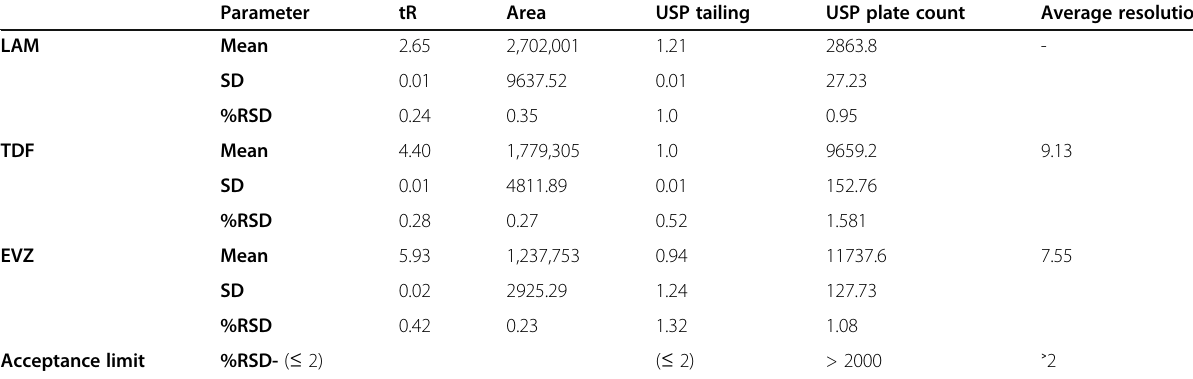
Table 2 Results of system suitability parameters of standard solution Parameter